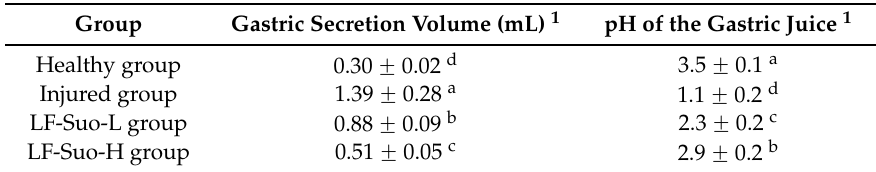
Table 3. Gastric secretion volume and pH of studied